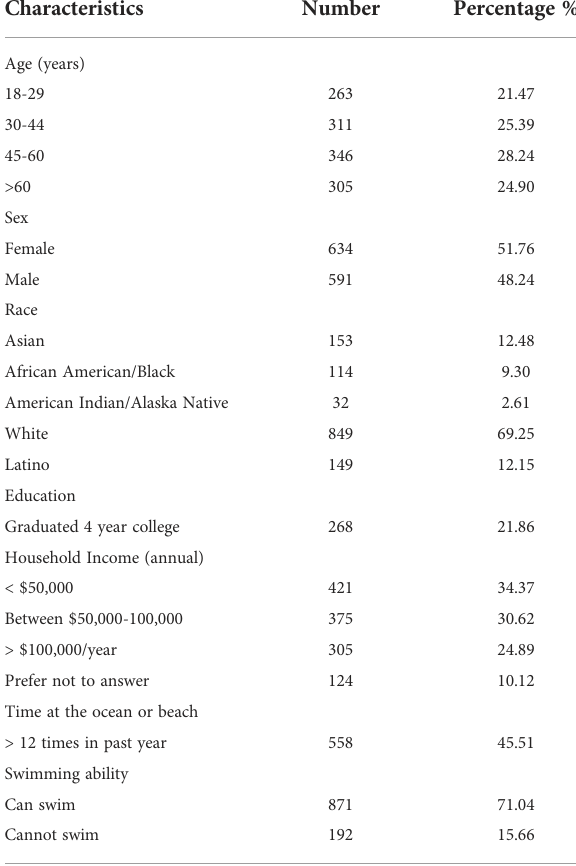
TABLE 1 Characteristics of the study population